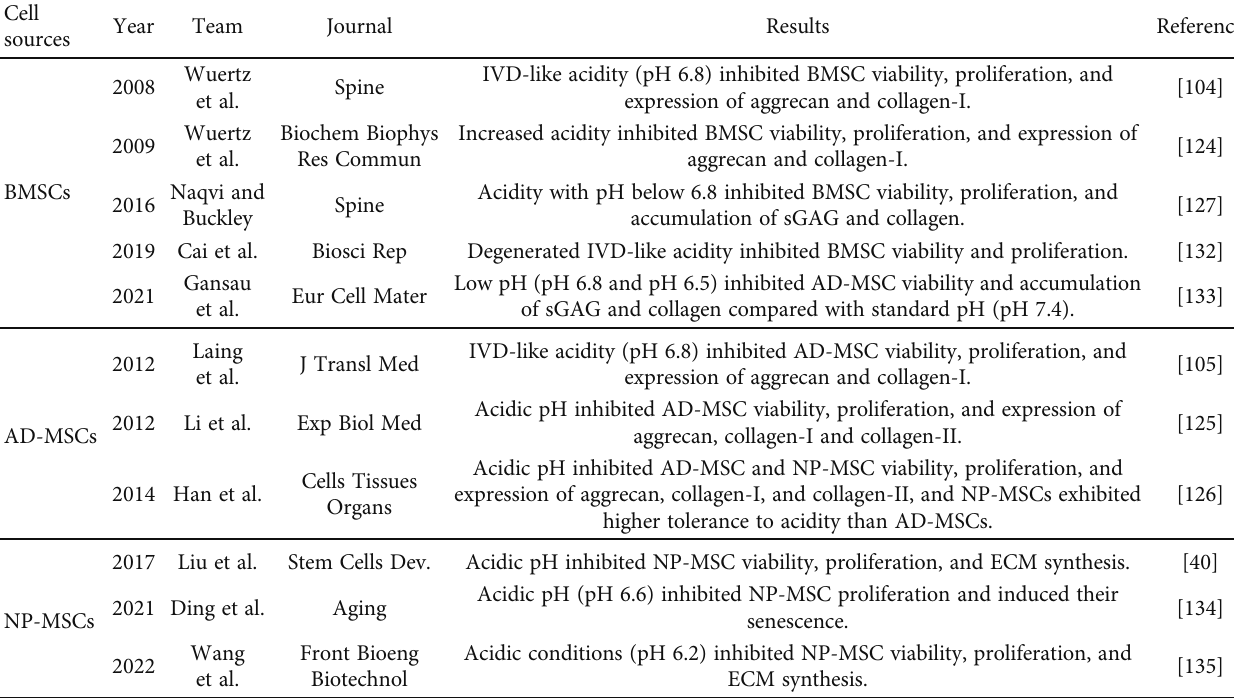
Table 4: E ff ects of pH on the biological behavior of